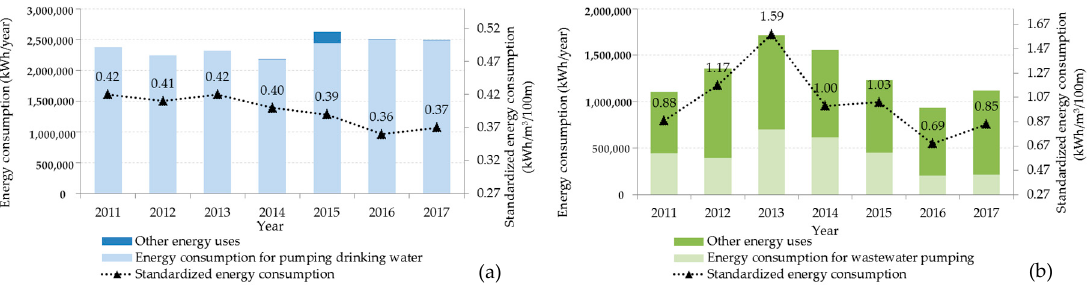
Figure 3. Water Utility K’s energy baseline between 2011 and 2017 for energy consumption and Standardised energy consumption by ( a ) drinking water systems, ( b ) wastewater systems.